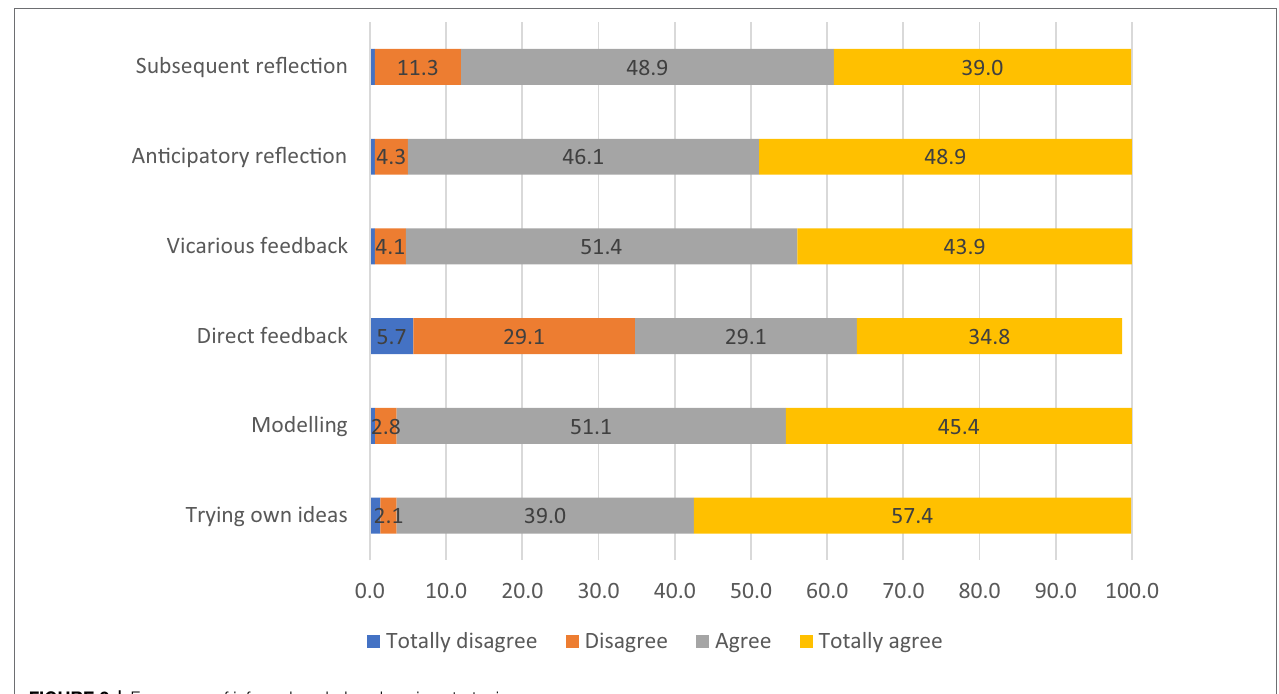
FIGURE 2 | Frequency of informal workplace learning strategies.